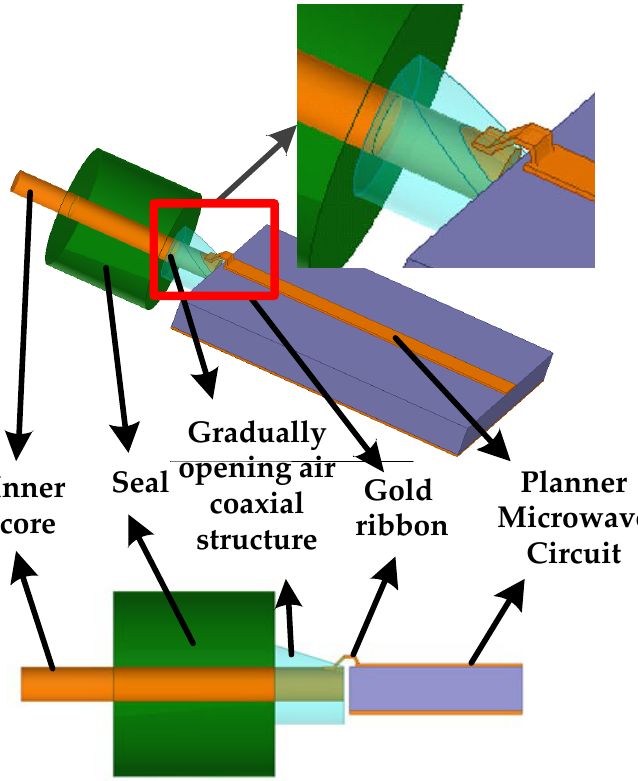
Figure 10. Structure diagram of the novel horizontal interconnection.